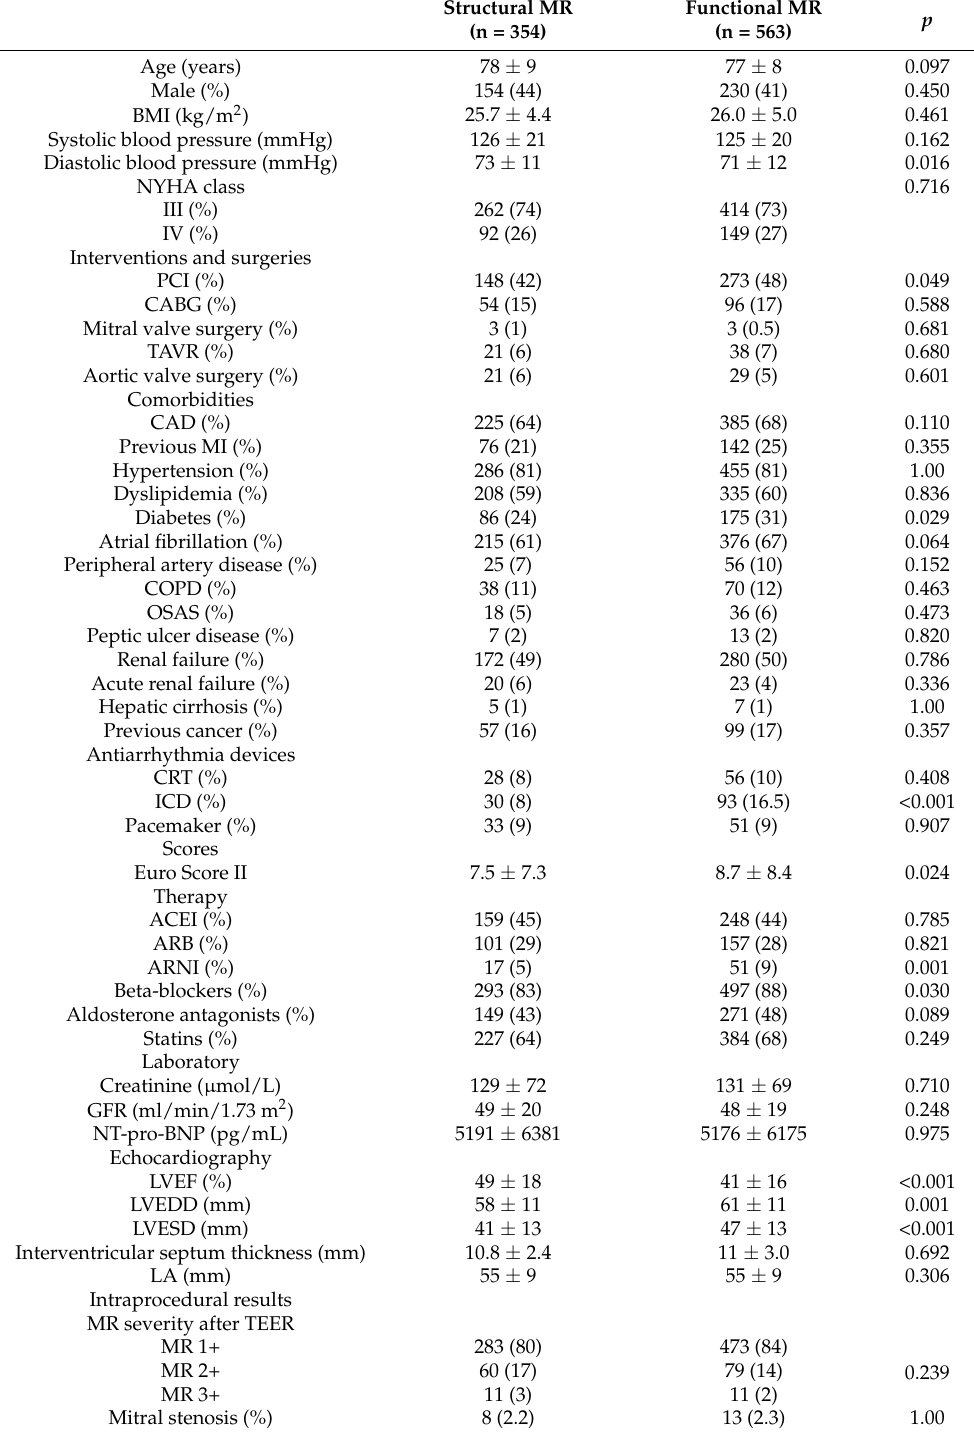
Table 1. Demographic characteristics and clinical parameters of study